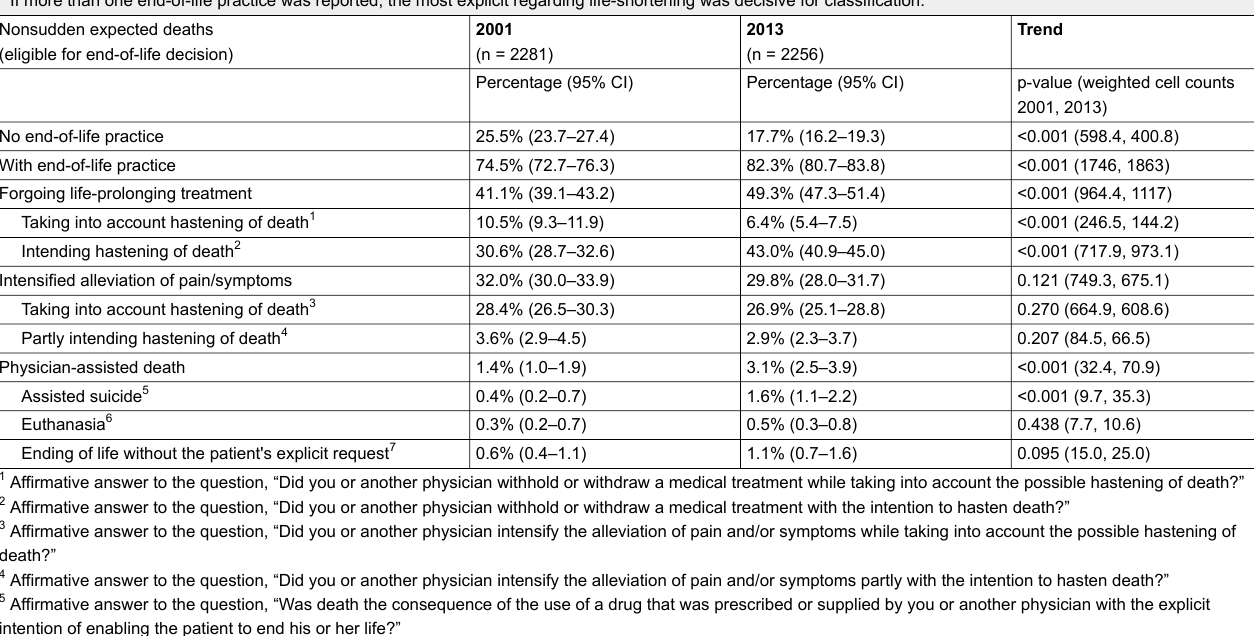
Table 1: Prevalence of medical end-of-life practices* in the German-speaking part of Switzerland, 2001 vs 2013 (100% = all non-sudden expected deaths; percentages weighted and standardized to 2013 deaths). * If more than one end-of-life practice was reported, the most explicit regarding life-shortening was decisive for classification. Nonsudden expected deaths (eligible for end-of-life